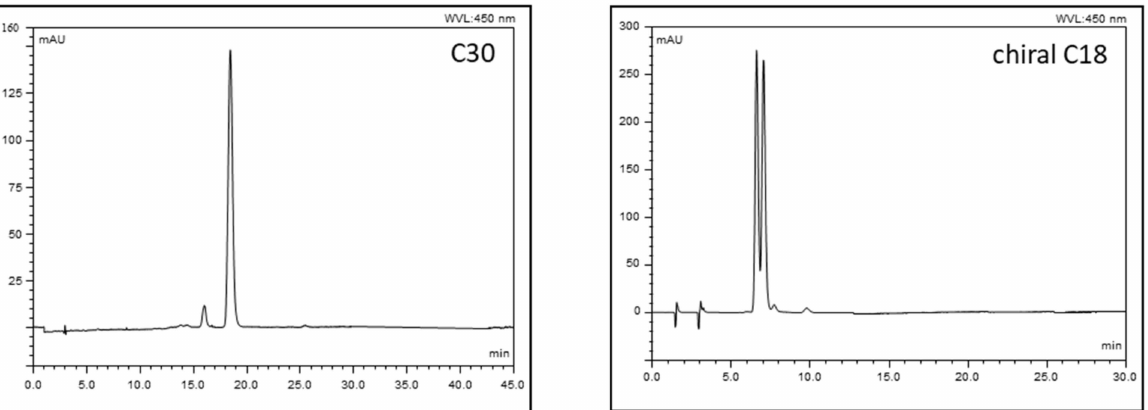
Figure 7. HPLC separation of β -cryptoxanthin 5 (cid:48) ,6 (cid:48) -monoepoxides. C 30 Conditions: see Figure 4. Chiral chromatography conditions: Chiralcel OD C18 3 µ m stat. phase (250 × 4.6 mm), 22 ◦ C. Eluents: A: MeOH/EtOH = 50/50 v / v %, B: MeCN/EtOH = 50/50 v / v %. Gradient program: from 0% B to 100% B eluent in 30 min. Flow rate: 1.00 cm 3 /min; λ = 450 nm. NMR detection is the best method for the identification of unknown